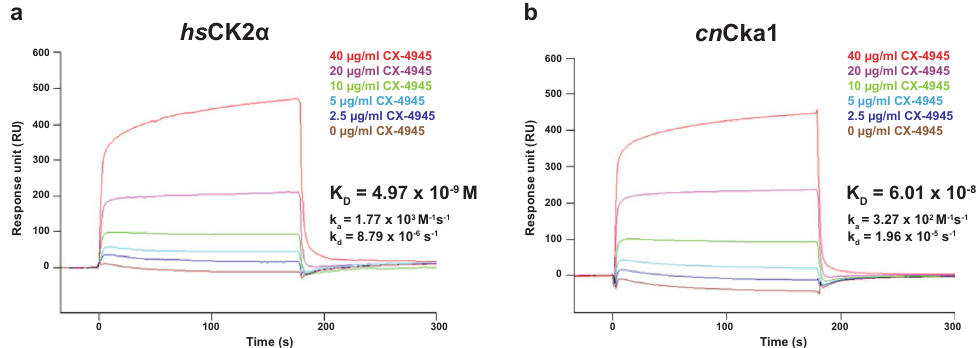
Figure 5. Surface plasmon resonance sensorgrams showing the interactions of hs CK2 α and cn Cka1 with the inhibitor CX-4945. ( a ) Interaction between hs CK2 α and CX-4945. ( b ) Interaction between cn Cka1 and CX- 4945.